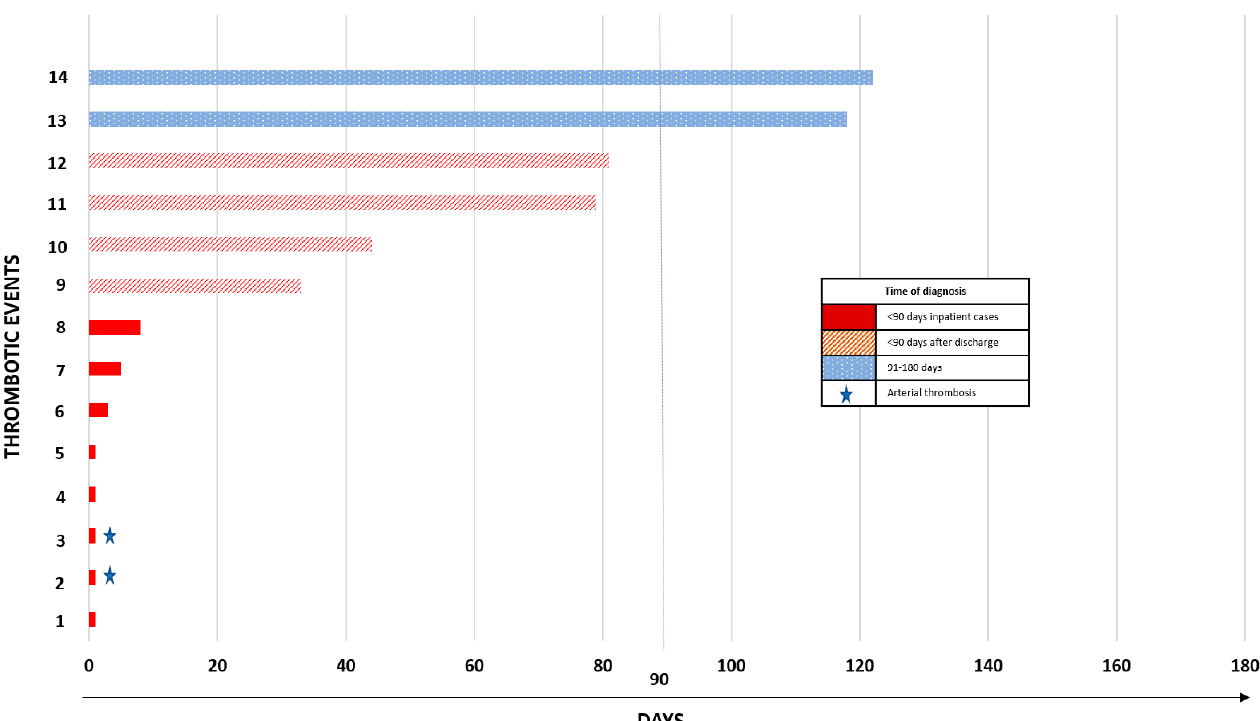
Figure 2. Thrombotic events over the course of 180 days after COVID-19 diagnosis. Table 2. Comparison between patients with and without thrombosis.